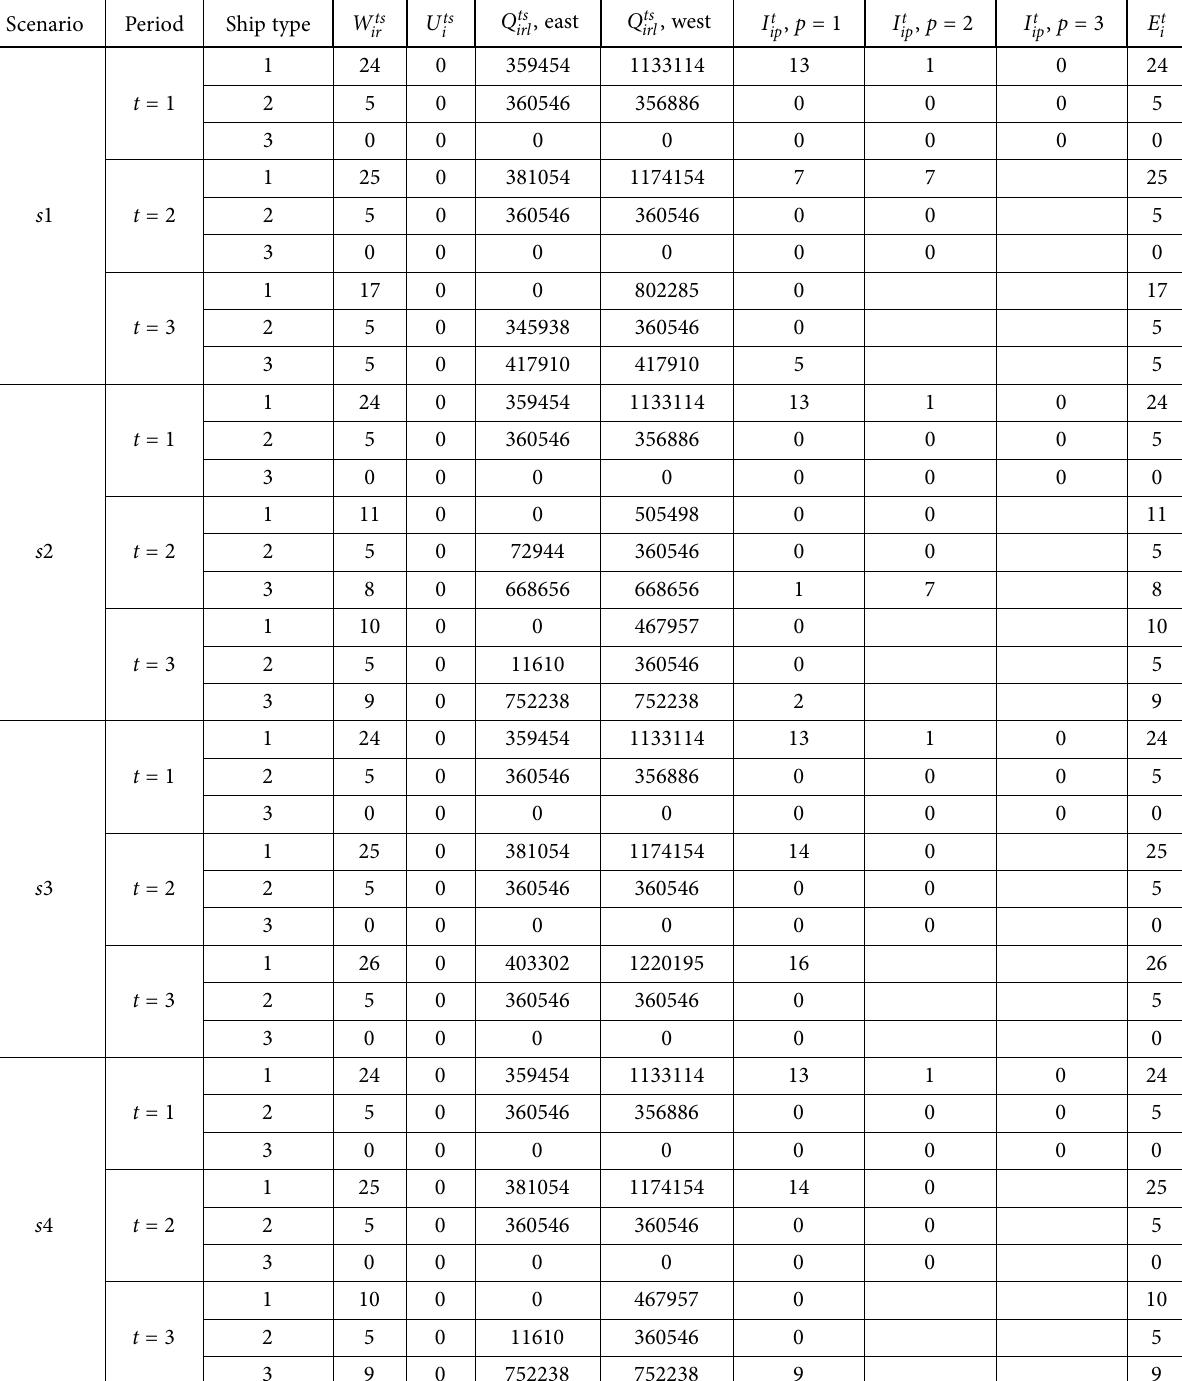
Table 5. Decision variables and objective function under different